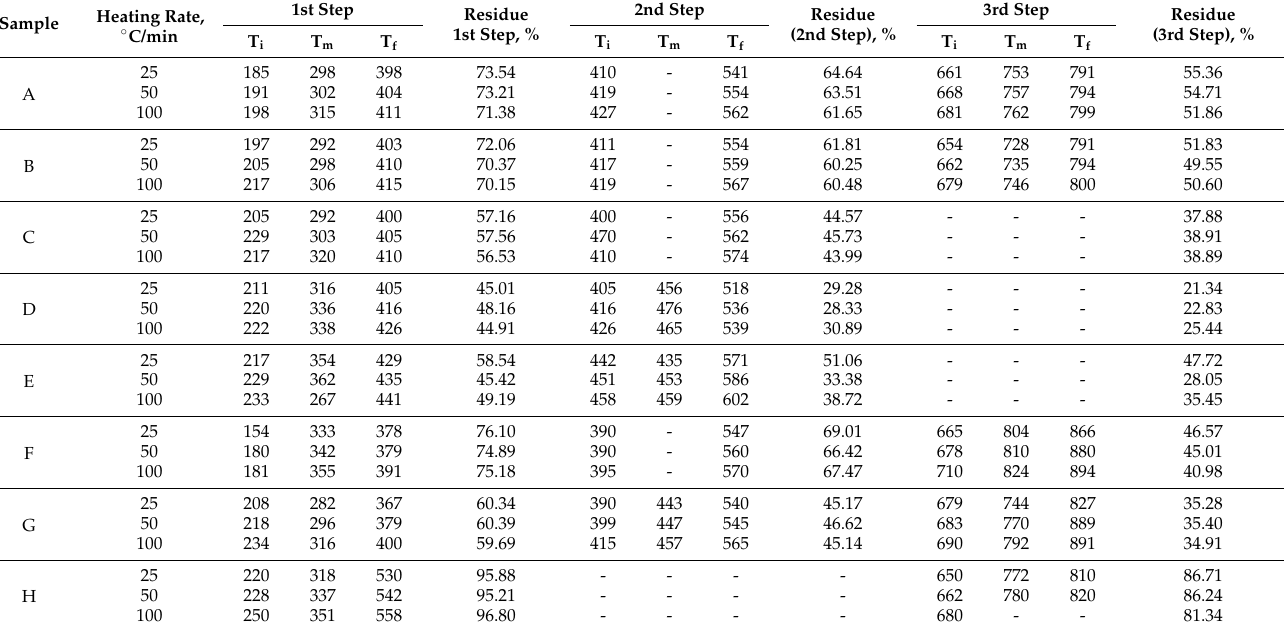
Figure 2. Summarized weight losses and dm/dt values. Table 3. Main temperatures of the